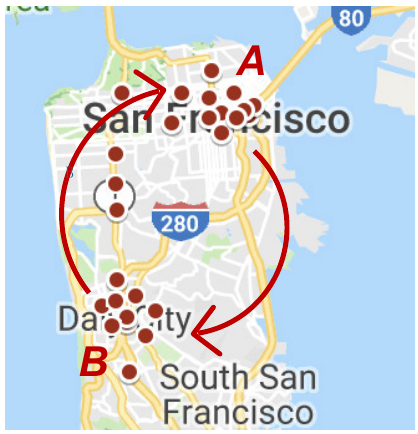
Figure 1. An illustrative example of the privacy threat caused by location semantics, where red points represent the locations that an individual visited. Especially, two regions where points concentrate are represented by red letters A and B respectively. We observe two periodic movement patterns, i.e., leaving from A to B and returning periodical. Suppose that the categories of A and B are residential district and business district, respectively. Then, A and B have a great chance to be home and workplace,